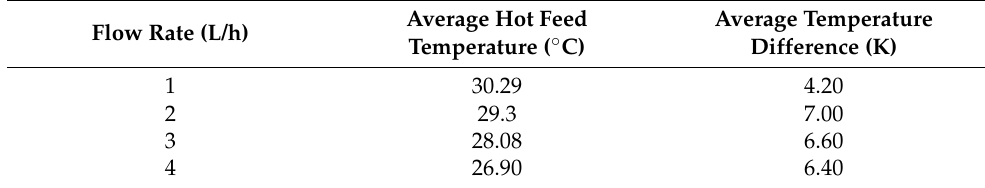
Table 3. Average hot feed temperature and temperature difference between on/off in pseudo-steady state.